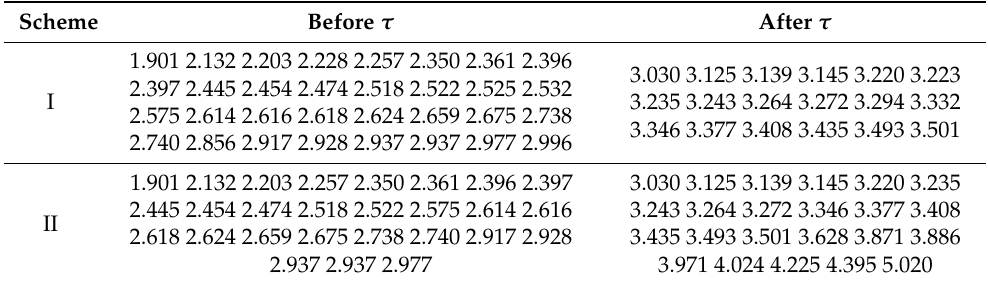
Table 8. The single carbon fiber study data based on SSPALT when τ = 3 and δ = 3.8. Scheme Before τ After τ